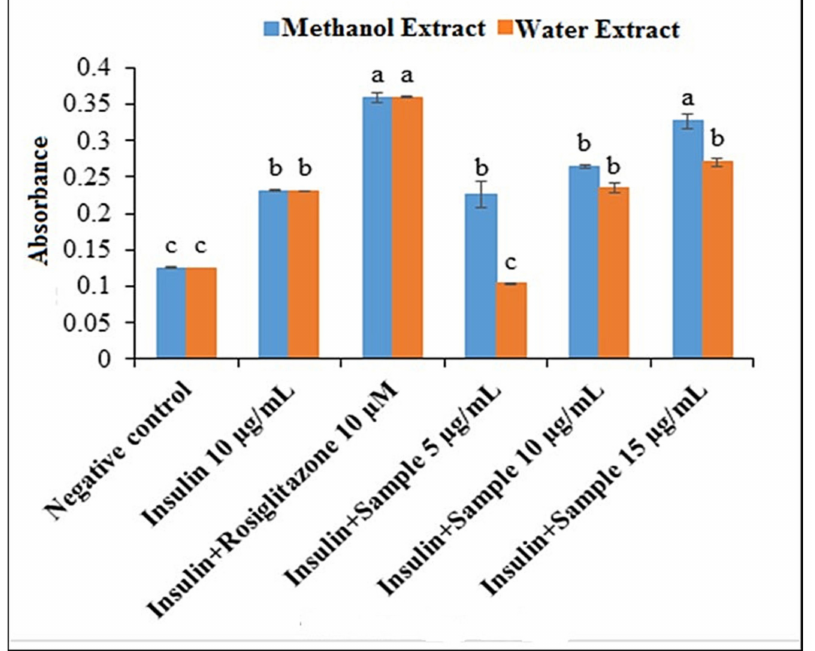
Figure 2. The effect of methanol and water extracts on glucose [2-NBDG] uptake measurement of 3T3-L1 adipocyte cells. Data with a different letter are significantly different with a p -value less than 0.05. Tukey’s multiple comparison test was used to calculate the data with a 95% confidence level; n =